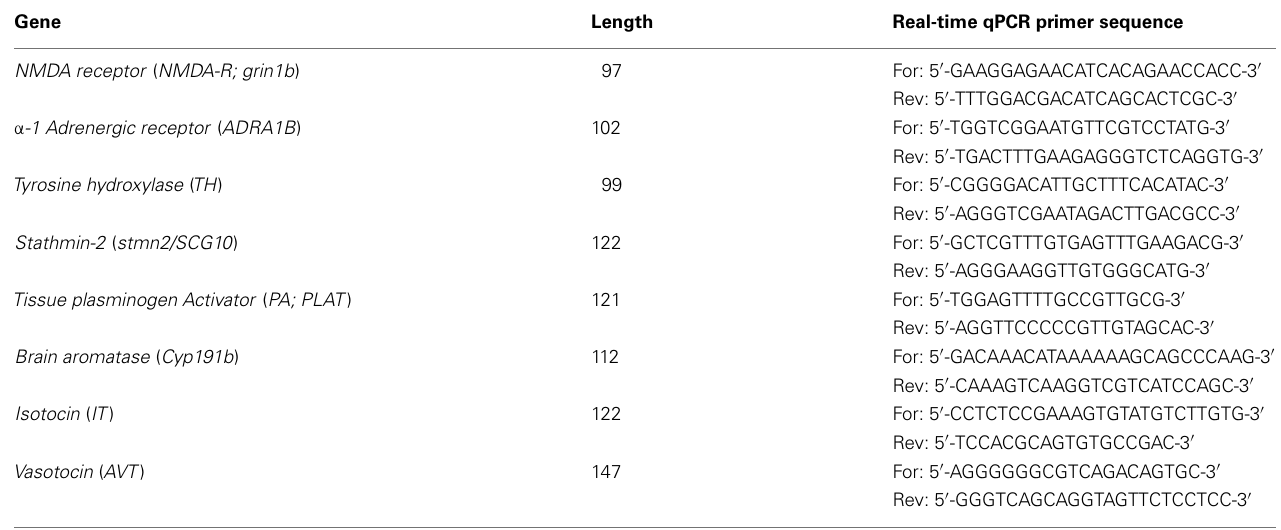
TableA2 | Real-time qPCR primers and reaction